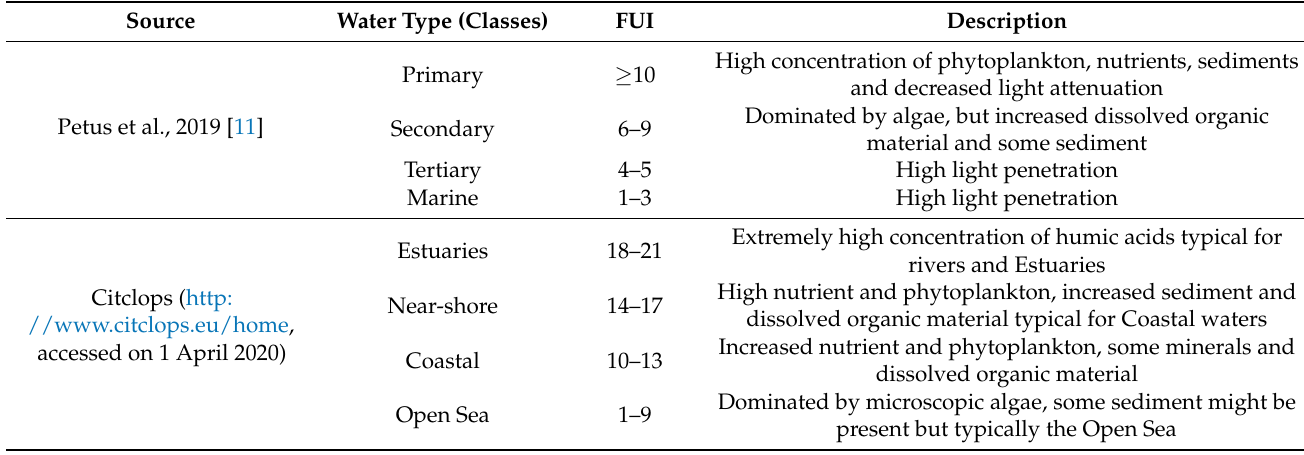
Figure 2. Measurement of water colour using a Secchi disk and Forel–Ule colour scale (source Reproduced with permission from Ceccarni et al., PLOS ONE, 2020, https://doi.org/10.1371/journal.pone.0230084. Table 1. Water type classification and their description.